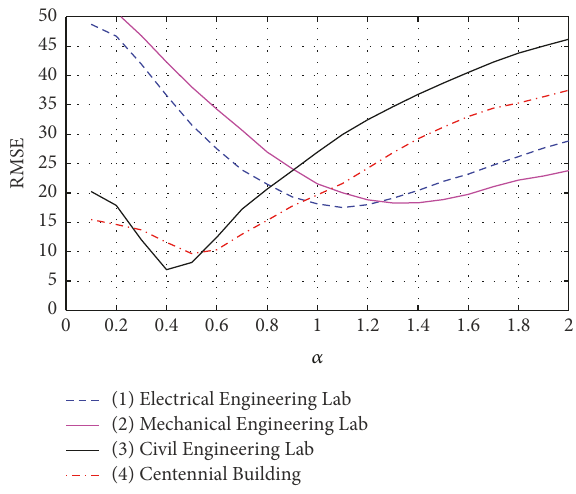
Figure 13: RMSE between simulation result and real experiment result.